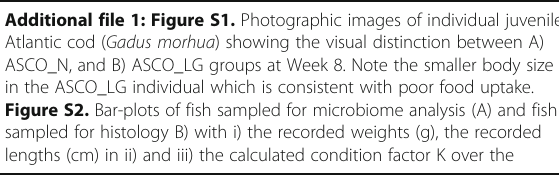
Figure S2. Bar-plots of fish sampled for microbiome analysis (A) and fish sampled for histology B) with i) the recorded weights (g), the recorded lengths (cm) in ii) and iii) the calculated condition factor K over